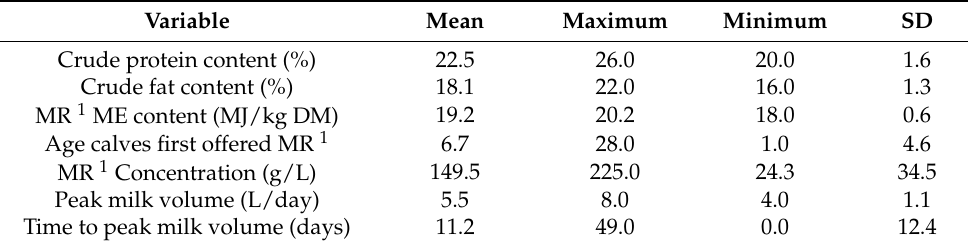
Table 2. Liquid feed nutrition of pre-weaned calves.